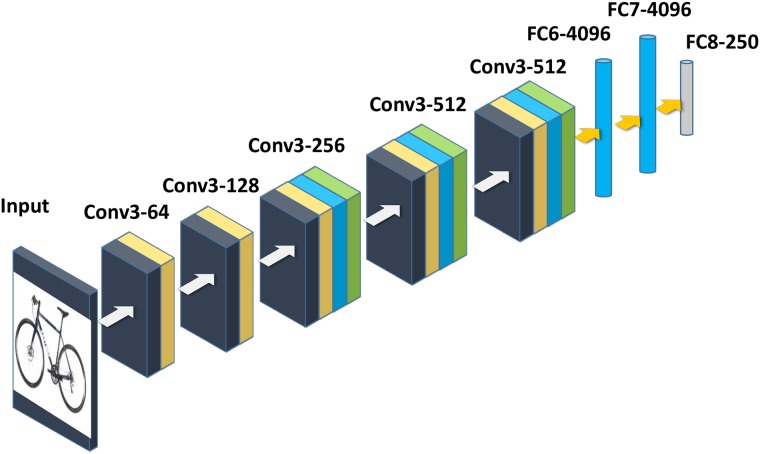
Architecture of the deep CNN for features extraction.